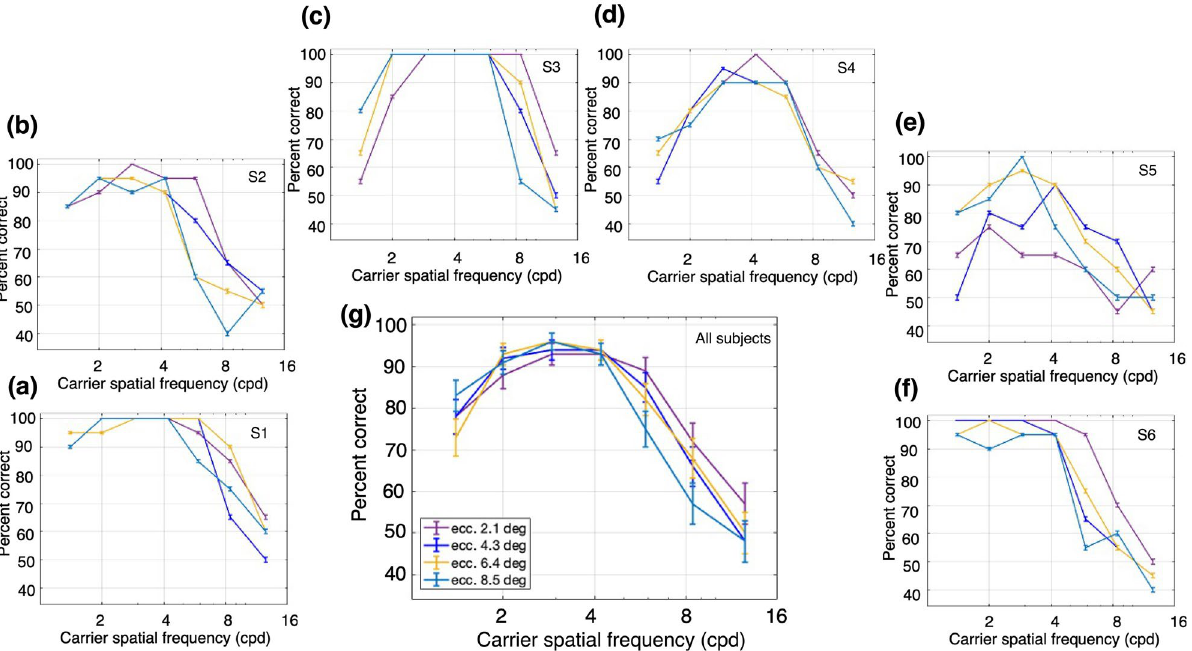
Figure 7. Performance for contrast modulation (CM) stimuli at different retinal eccentricities and a fixed carrier TF of 20 Hz. The stimuli consisted of a contrast-reversing grating (carrier) modulated by a drifting sinewave envelope with a SF of 0.5 cpd and a TF of 3 Hz. The task was to discriminate the direction of motion of the envelope when presented at different retinal eccentricities. Percent correct responses were measured while varying carrier SF within blocks for different eccentricities: dark purple, fixation at 2.1°; dark blue, 4.3°; yellow, 6.4°; and light blue, 8.5°. ( a – f ) Percent correct responses for subjects 1 (S1) through 6 (S6). ( g ) Mean percent correct responses of the six subjects. Error bars represent the binomial SE of each condition for each subject ( a – f ) and the SEM (N = 6 subjects) for the subject-averaged results ( g